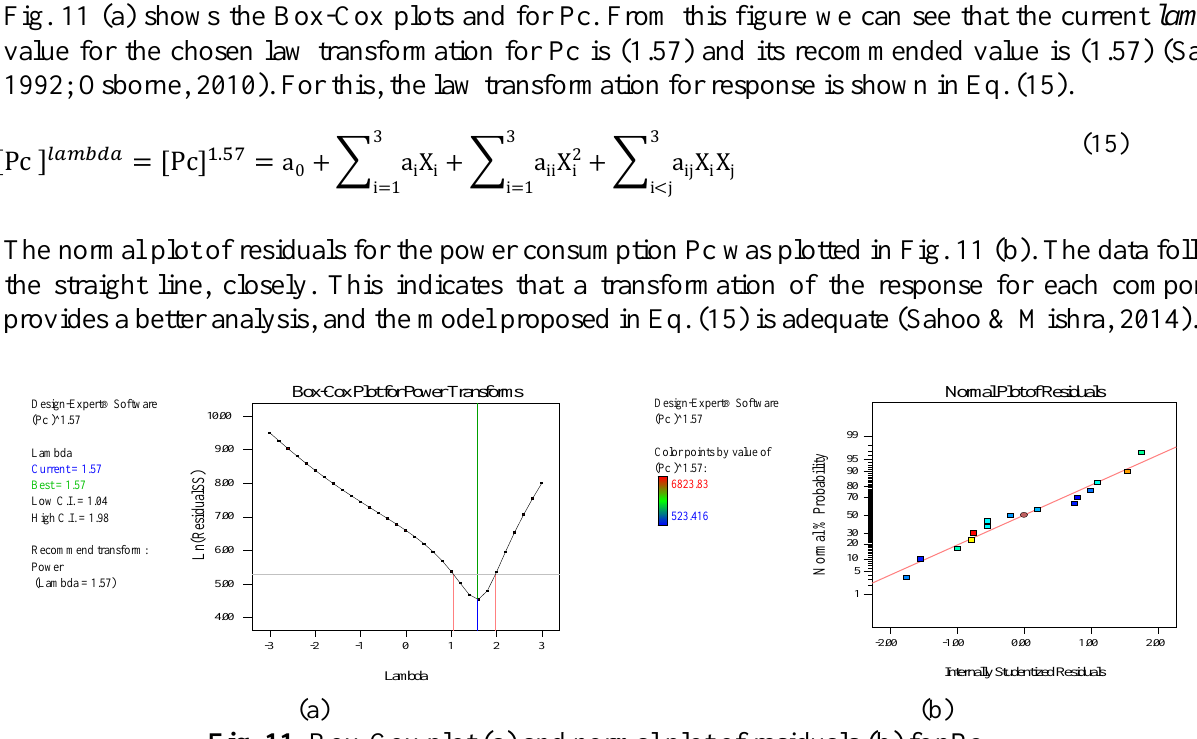
Fig. 11. Box-Cox plot (a) and normal plot of residuals (b) for